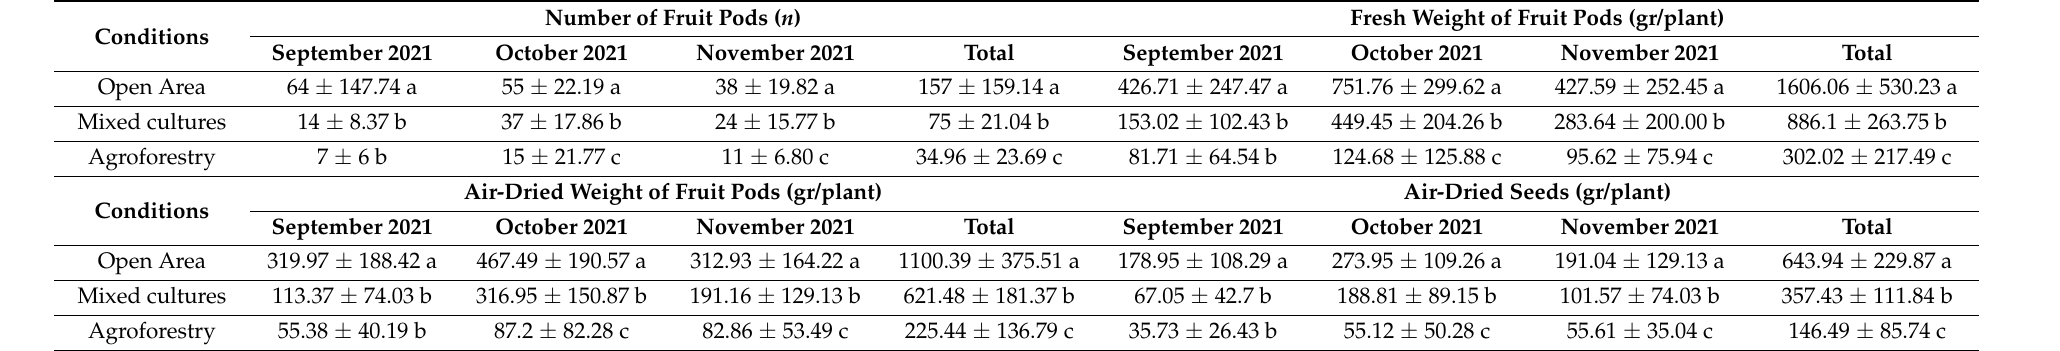
Table 3. Sacha Inchi monthly